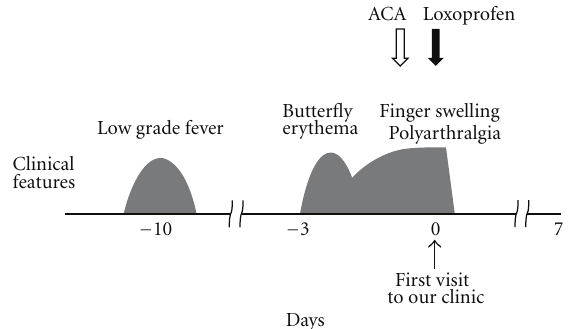
Figure 2: Clinical course of Case 2 . Ten days prior to her visit, the patient had a low grade fever. Seven days later, she developed a butterfly-shaped erythema, followed by swelling of her fingers and polyarthralgia. Immediately after the initiation of loxoprofen, the symptoms quickly disappeared within 12 hours. There was no recurrence of the symptoms or signs afterwards. ACA,